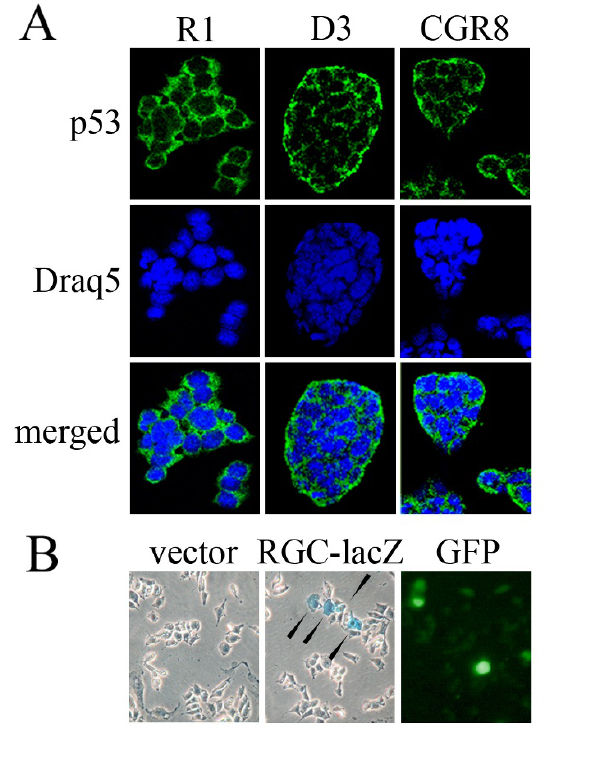
Figure 1 Cytoplasmic localisation of p53 in proliferating ES cells . R1, D3 and CGR8 mouse embryonal stem cells were plated on cover slips (R1 and D3 in the presence of feeders, CGR8 in the absence of feeders). Two days after plating, cells were fixed in acetone/methanol, permeabilized with Triton- X-100 and incubated with the anti-p53 antibody Pab 421. After incubation, cover slips were washed and incubated with an antibody directed against mouse IgG, coupled to Alexa-Fluor-488 (green). To visualize the nuclei, cover slips were incubated with Draq5 (blue). (B) R1 ES cells were transfected with RGC-lacZ or with a vector control together with GFP to visualize transfection efficiency. Two days after transfection, cells were fixed with paraformaldehyde and incubated with X-gal in reaction buffer to monitor β -galac- tosidase expression. Arrows point to lacZ expressing R1